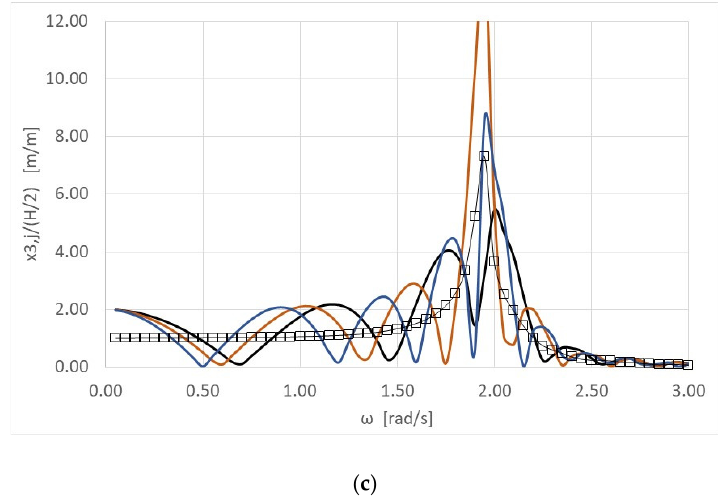
Figure 8. Dimensionless heave displacement of the 3rd WEC, j = 3, of the array arranged perpendicularly to the wall, against ω , for three different examined distances from the vertical wall and three wave heading angles. Comparisons are made for the heave displacements of the same converter of the array without the presence of the breakwater: ( a ) θ = 0°; ( b ) θ = 45°; ( c ) θ = 60°.